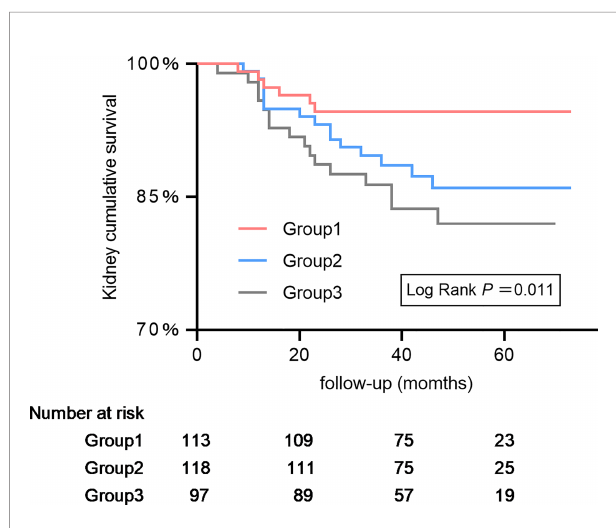
FIGURE 3 | Kaplan – Meier kidney survival curves of participants with idiopathic membranous nephropathy according to serum complement 4. The time zero was kidney biopsy. The division between the three groups of participants was on the basis of tertiles of complement 4.